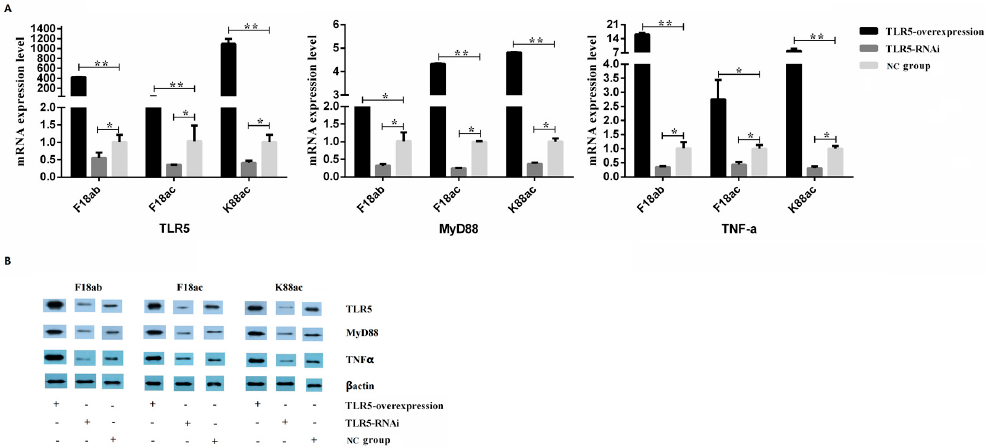
Figure 3. Expression levels of TLR5 , MyD88 , and TNF- α in IPEC-J2 cells following E. coli stimulation. Expression differences of TLR5 , MyD88 , and TNF- α were detected by qPCR ( A ) and western blot ( B ). *, p < 0.05; **, p < 0.01.